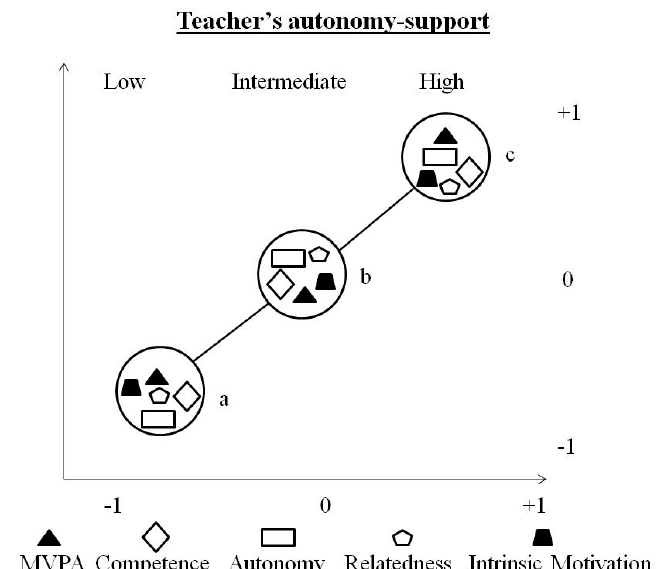
Figure 1. Graphical representation of the research hypothesis. Note. y-axis = levels of autonomy support; x-axis = basic psychological needs and intrinsic motivation.